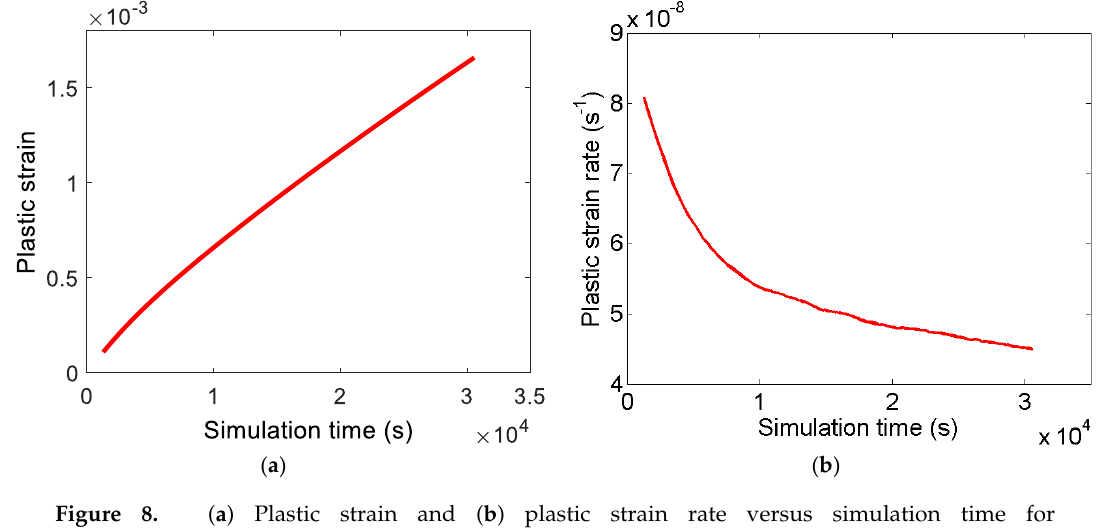
Figure 8. ( a ) Plastic strain and ( b ) plastic strain rate versus simulation time for M glide = 1.44 × 10 −9 (Pa·s) −1